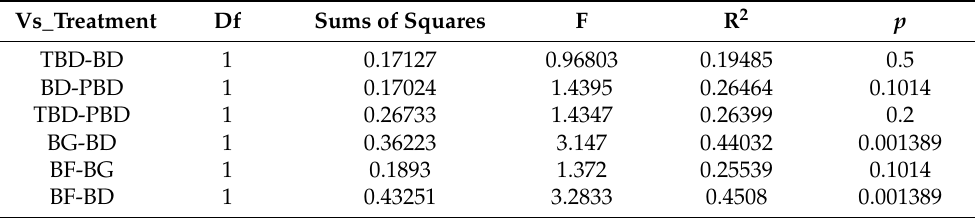
Df, degree of freedom; Sums of Squares, sum of deviation squares. BD, biochar − organic fertilizer; TBD, Trifolium repens L. cover crops − biochar − organic fertilizer; PBD, Paspalum wettsteinii cover